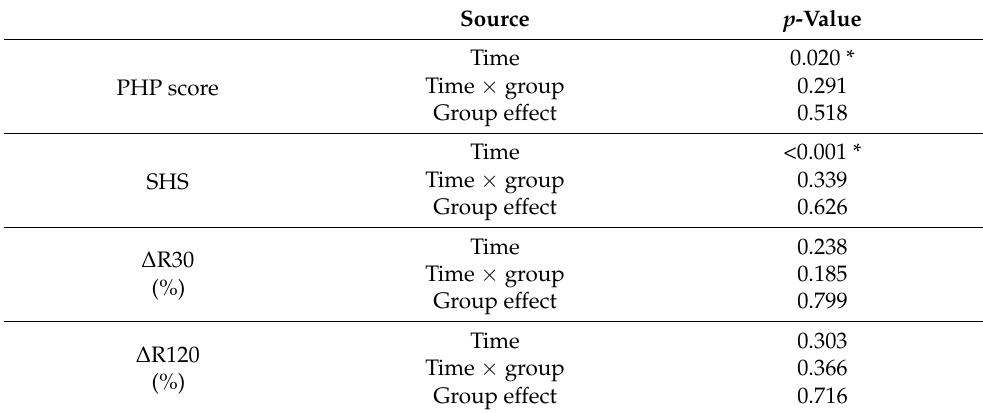
Table 3. Time effects on variables of oral hygiene status in the three groups.